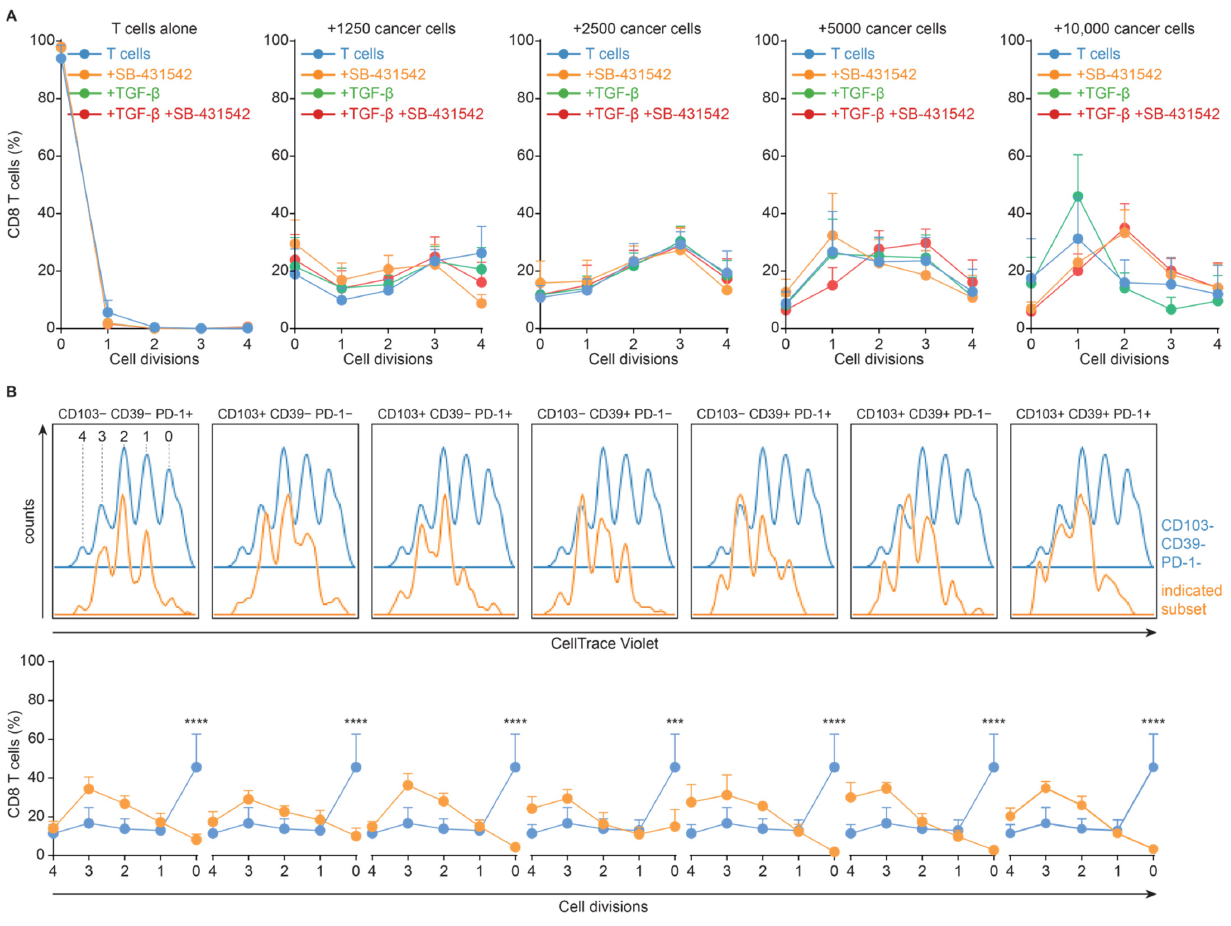
Figure 5. ( A ) Relative number of cell divisions across the indicated culture conditions and the ratio of aAPCC: T cell. ( B ) Representative CellTrace Violet traces for the indicated CD8+ T cell subsets ( top ) and the relative number of cell divisions for the indicated CD8+ T cell subsets ( bottom ). aAPCC were seeded at the indicated concentration in a 96-well, allowed to adhere for 24 h and 10,000 T cells were added to each well for co-culture. **** = p <